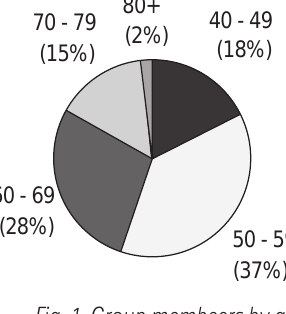
Fig. 1. Group membeers by